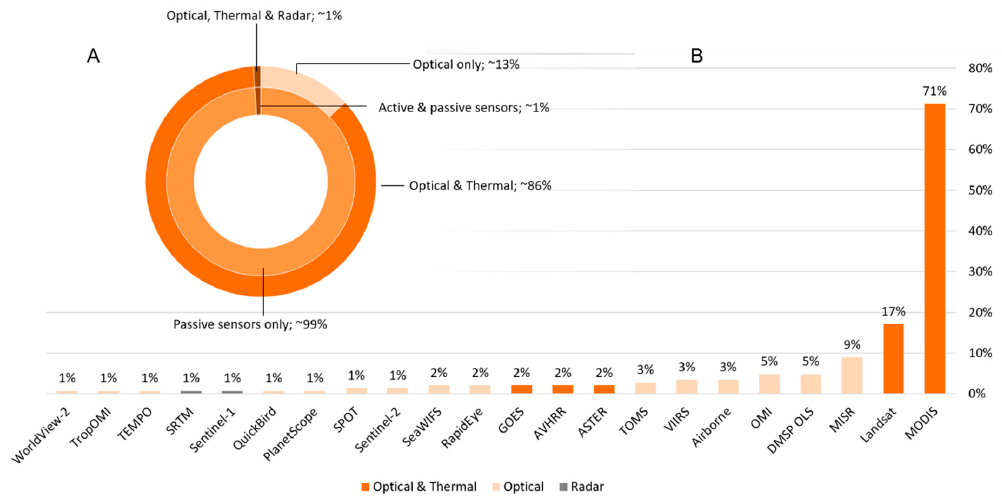
Figure 7. Overview of sensor type used in the studies investigated ( A ) and sensors used as relative share of entirety of reviewed studies ( B ).